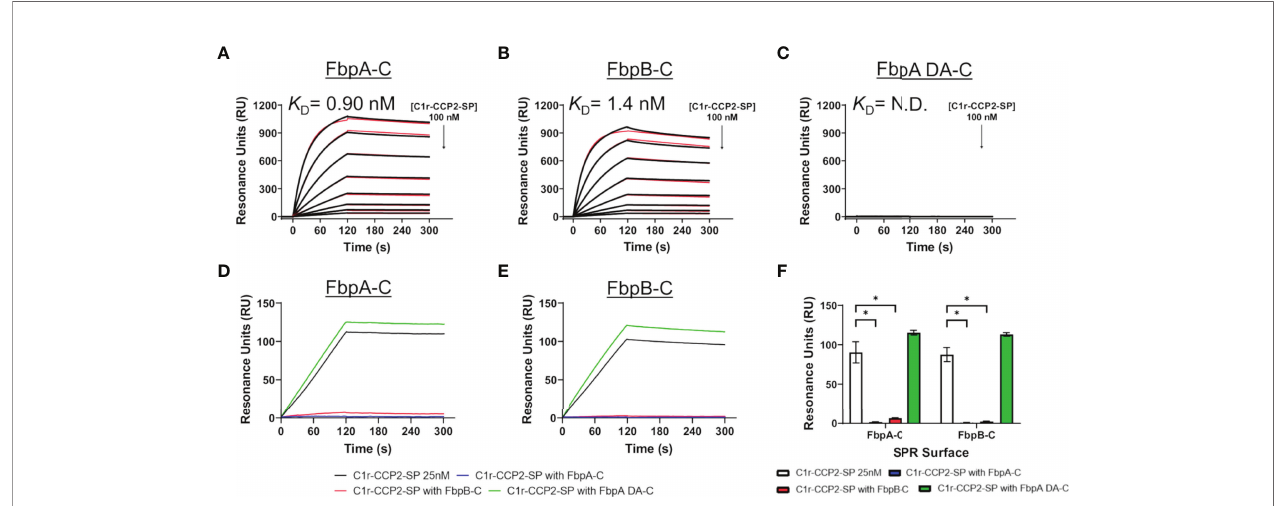
FIGURE 3 | Assessing the interaction of human C1r with B. miyamotoi FbpA and FbpB. SPR was used to assess protein-protein interactions between the C- terminal regions of each Fbp protein and activated C1r-CCP2-SP. Immobilized (A) FbpA-C, (B) FbpB-C, and (C) FbpA-C-R264A-K343A (referred to as FbpA DA-C throughout) were subjected to an injection series of serially diluted C1r-CCP2-SP (0.78 - 100 nM). A representative sensorgram from the three replicates for each Fbp is shown with the black curve being the sensorgram and the red curve the associated kinetic fi t. K D values were determined using kinetic fi ts and are shown as the mean +/- standard deviation of three replicates in Table 4 . A K D value for C1r-CCP2-SP interactions with FbpA DA-C was not determined (N.D.). (D, E) Competition experiments were carried out using 25 nM C1r-CCP2-SP alone or mixed with 25 nM soluble Fbp proteins injected over FbpA-C (D) or FbpB-C (E) . (F) Comparisons of statistical signi fi cance were performed for data shown in panels (D, E) using a one-way ANOVA followed by a multiple comparison Tukey test (* = p < 0.05).